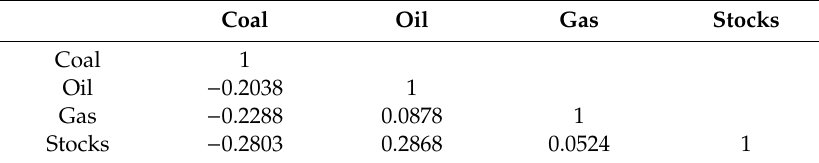
Table 19. Correlations for Switzerland.